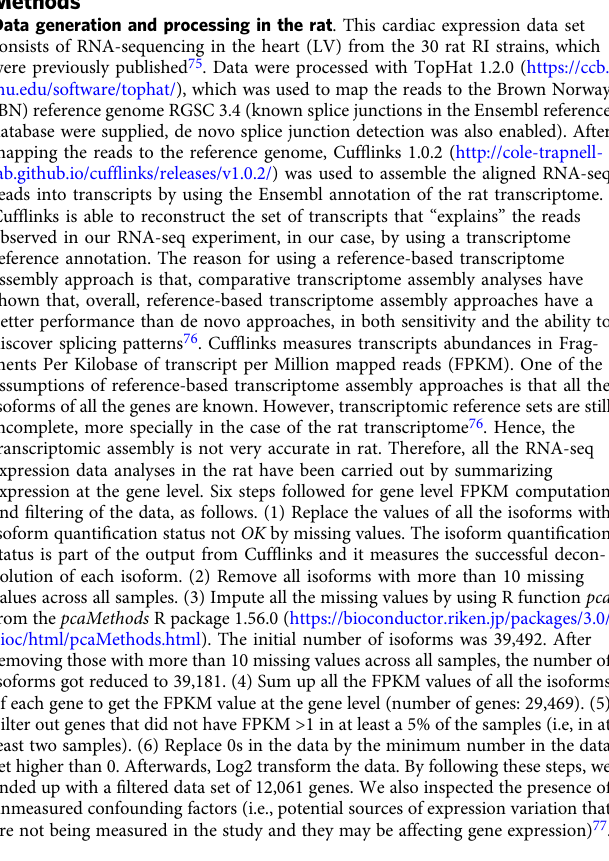
Fig. 5 WWP2 regulates the nucleocytoplasmic shuttling and TGF β -signal transduction activity of SMAD2. a Immuno fl uorescence analysis of WWP2 in WT primary cardiac (myo) fi broblasts shows nuclear localization after 16 h TGF β 1 stimulation. Scale bar: 20 μ m. b Immunoblotting for WWP2 isoforms in WT (myo) fi broblasts reveals that upon 16 h TGF β 1 stimulation, there is an increased amount of WWP2-FL and -N isoforms in the nuclear extraction. c Representative WB of p-SMAD2 and SMAD2 protein levels in WT and WWP2 Mut/Mut (myo) fi broblasts with or without TGF β 1. d In-cell ubiquitylation of SMAD2 in primary (myo) fi broblasts from both WWP2 Mut/Mut and WT mice. Cells were treated with MG132 (10 μ M, 3 h) followed by TGF β 1 (5 ng/ml, 6 h). Lysates were prepared from WWP2 Mut/Mut and WT (myo) fi broblasts and then were subjected to immunoprecipitation with anti-SMAD2 antibodies, followed by western blotting probed with antibodies as indicated. e Quanti fi cation of TGF β 1-induced luciferase reporter activity of SMAD2 in WT and WWP2 Mut/Mut (myo) fi broblasts ( P values calculated by Mann – Whitney U test; n = 4 for each group; data reported as means ± SD) f WB showing SMAD2 and SMAD4 protein distribution in cytoplasmic and nuclear fractions of WT and WWP2 Mut/Mut (myo) fi broblasts after TGF β 1 stimulation (16 h). WCL whole-cell lysis, Cyto cytoplasmic, Nuc nuclear. g Top: representative immunostaining of SMAD2 in WT and WWP2 Mut/Mut (myo) fi broblasts treated with TGF β 1 for 1 h and then with SB431542 for 5 h. Scale bar: 50 μ m. Bottom: quanti fi cation analysis shows delayed exportat of SMAD2 from the nucleus in the WWP2 Mut/Mut group ( fi ve biological replicates, eight images each; P values calculated by Mann – Whitney U test; data reported as means ± SD). h Schematic of the proposed model for the WWP2-mediated regulation of SMAD2 nucleocytoplasmic shuttling in cardiac fi